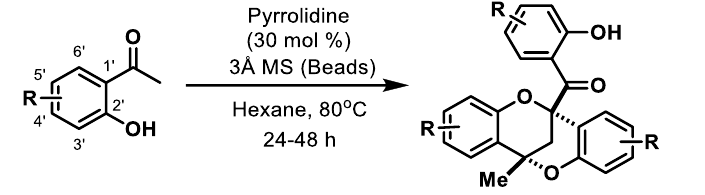
Figure 1. Synthesis of methanodibenzo[ b , f ][1,5]dioxocins 1 – 7.